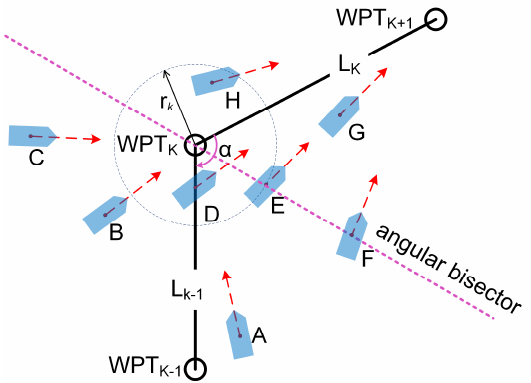
Figure 7. Waypoint (WPT) selection algorithm for offline path planning.